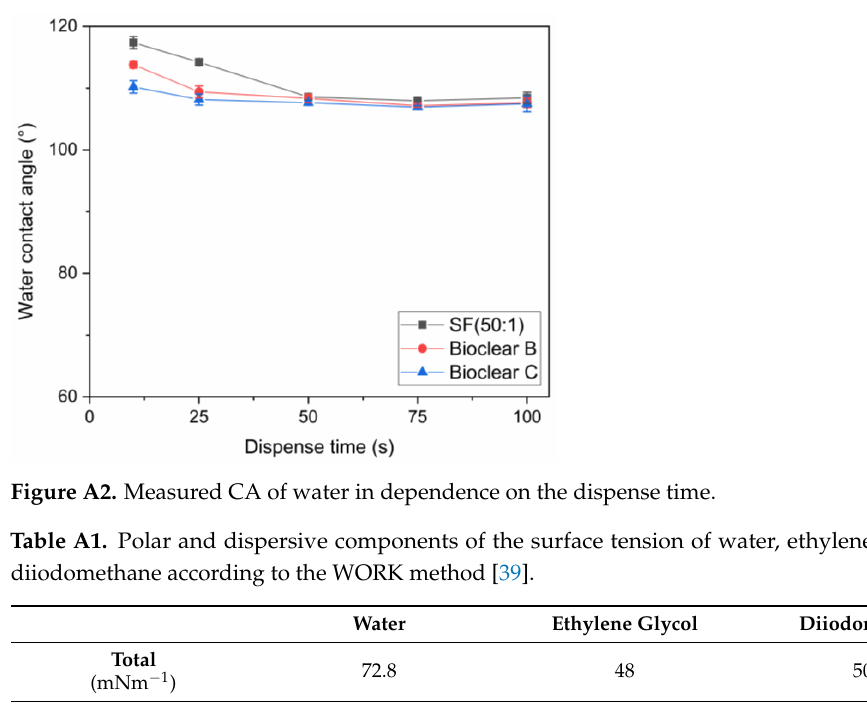
Figure A1. Gel-permeation chromatography (GPC) elution spectrums of normalized distributions vs. molar mass of components of SF (Part A), crosslinked SF (1:1), and the components of Bioclear (XG 0677, HMS151, DMS V31). The dashed line in both SF-Part A and SF (1:1) represents the inte- gration limit.